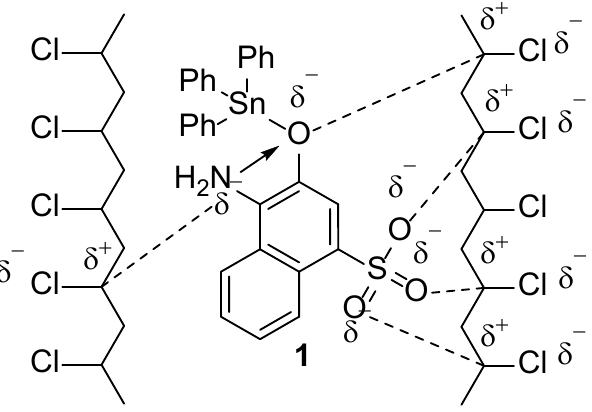
Figure 14. Attraction between PVC and Complex 1 .